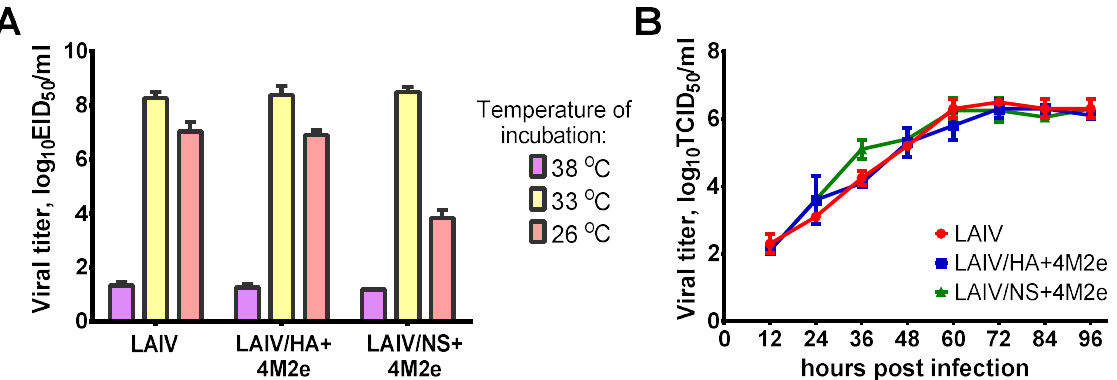
Figure 2. Growth characteristics of LAIV viruses used in this study. ( A ) Infectious viral titers in eggs incubated at different temperatures. ( B ) Kinetics of viral growth in MDCK cells at optimal temperature 33 ◦ C and multiplicity of infection 0.01.